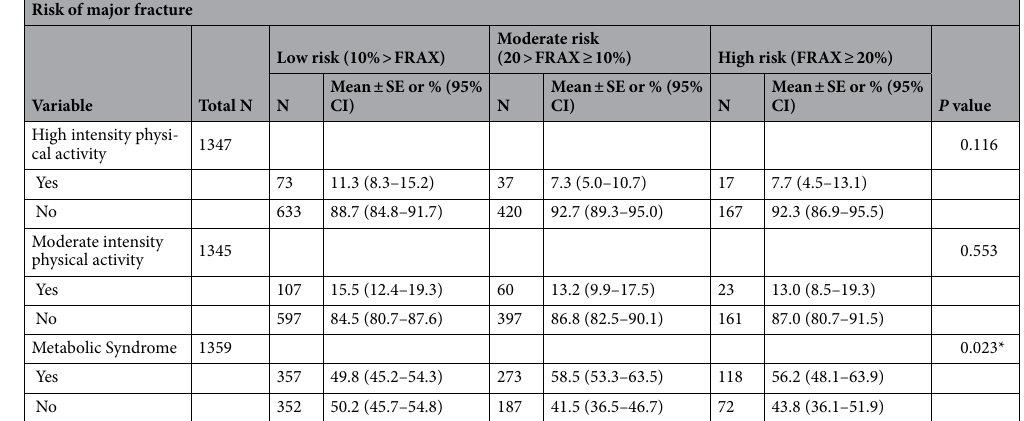
Table 1. Differences of sociodemographic characteristics and levels of physical activity accordance with the levels of probable risk of major fracture. BMI, body mass index; CI, confidential interval; SE, standard error. %Weighted percentage by column. Data obtained from Rao-Scott Chi-square test. † Data obtained from independent T-test and descriptive values are shown as mean ± SE. *P < 0.05, ** P < 0.001 by Chi-Square test or independent